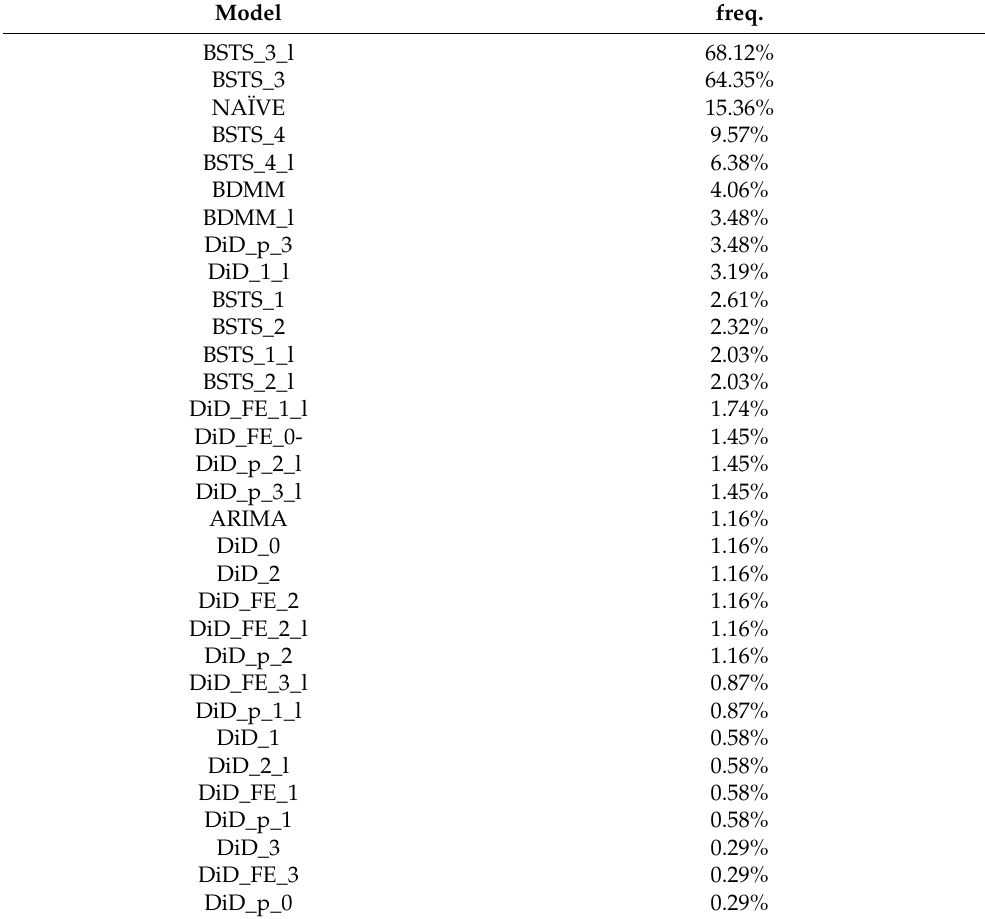
Table 7. Frequency of the presence of a given model in the superior model set created by MCS procedure. Model freq. BSTS_3_l 68.12% BSTS_3 64.35% NAÏVE